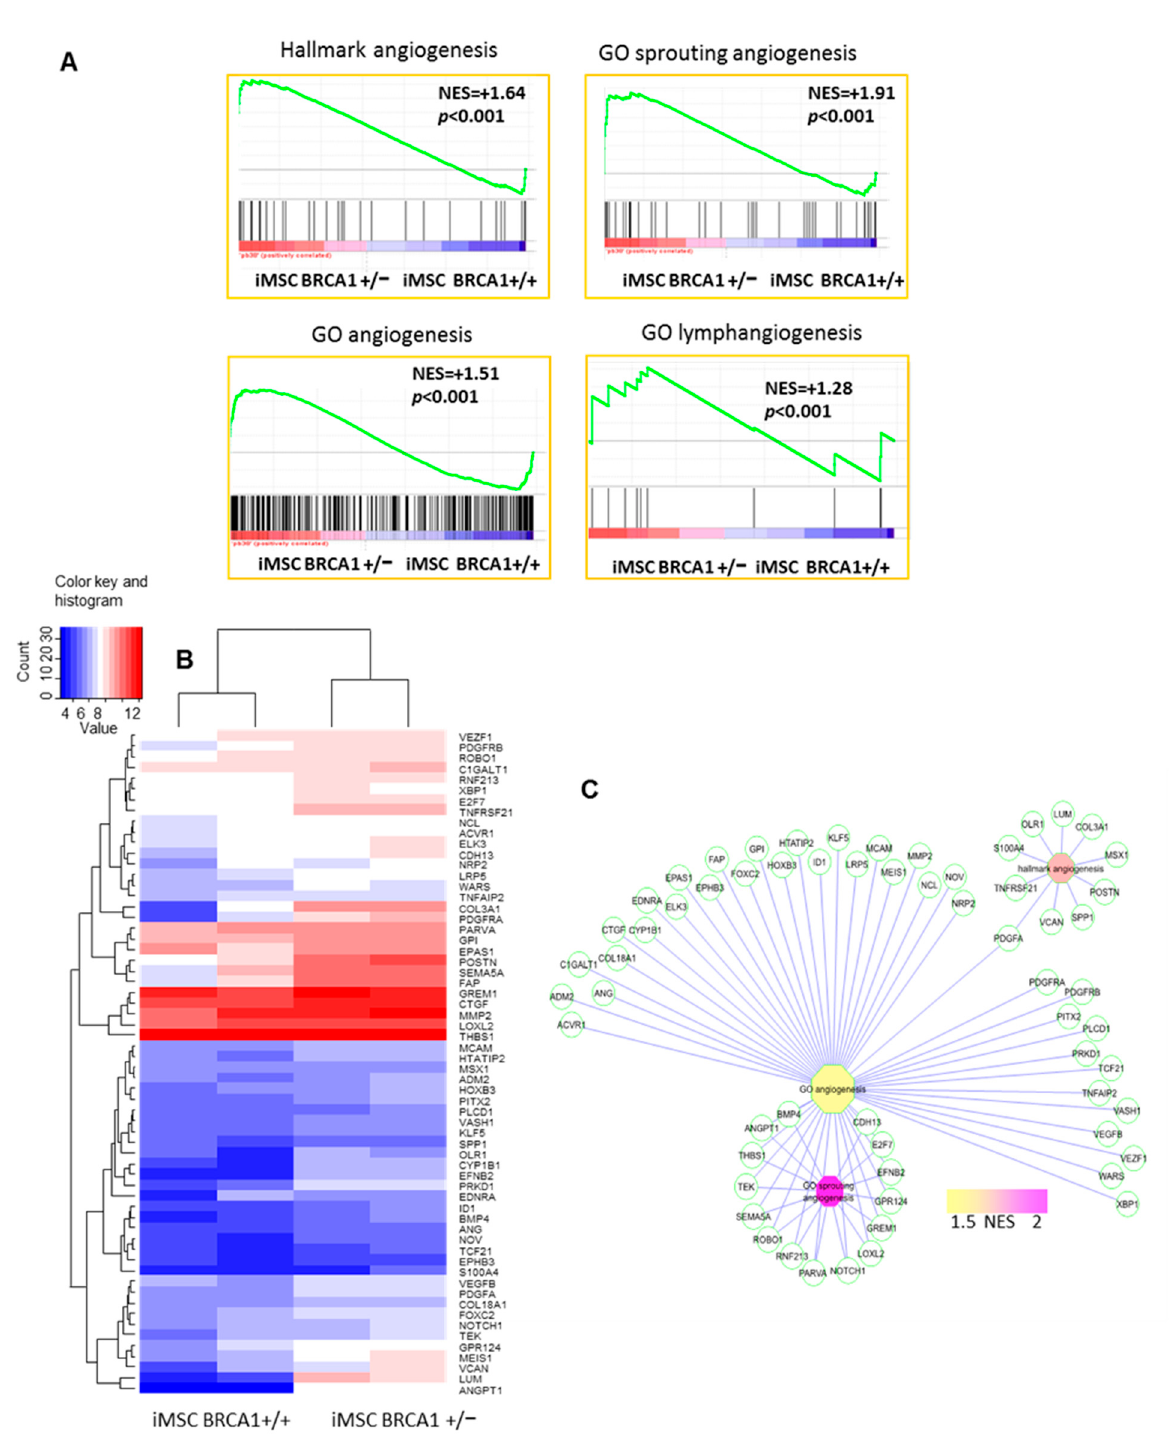
Figure 3. Angiogenesis-associated activity in the transcriptome of BRCA1 +/ − iMSCs. ( A ) Enrichment in angiogenesis- and lymphangiogenesis-related gene sets from the Hallmarks and Gene Ontology Biological Process gene set collections from MSigDB version 5.2 (NES: Normalized Enrichment Score). ( B ) Unsupervised clustering (Euclidean distances) of angiogenic genes that were upregulated in BRCA1 +/ − iMSCs. ( C ) Angiogenesis-related functional network created with genes upregulated in BRCA1 +/ − iMSCs compared to WT (NES: Normalized Enrichment Score).